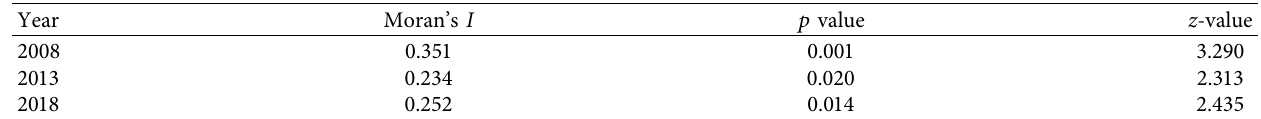
Figure 5: The spatial pattern of the UGDI in 2008, 2013, and 2018. (a) 2008. (b) 2013. (c) 2018. Table 3: Global Moran’s I index of the UGDI in 2008, 2013, and